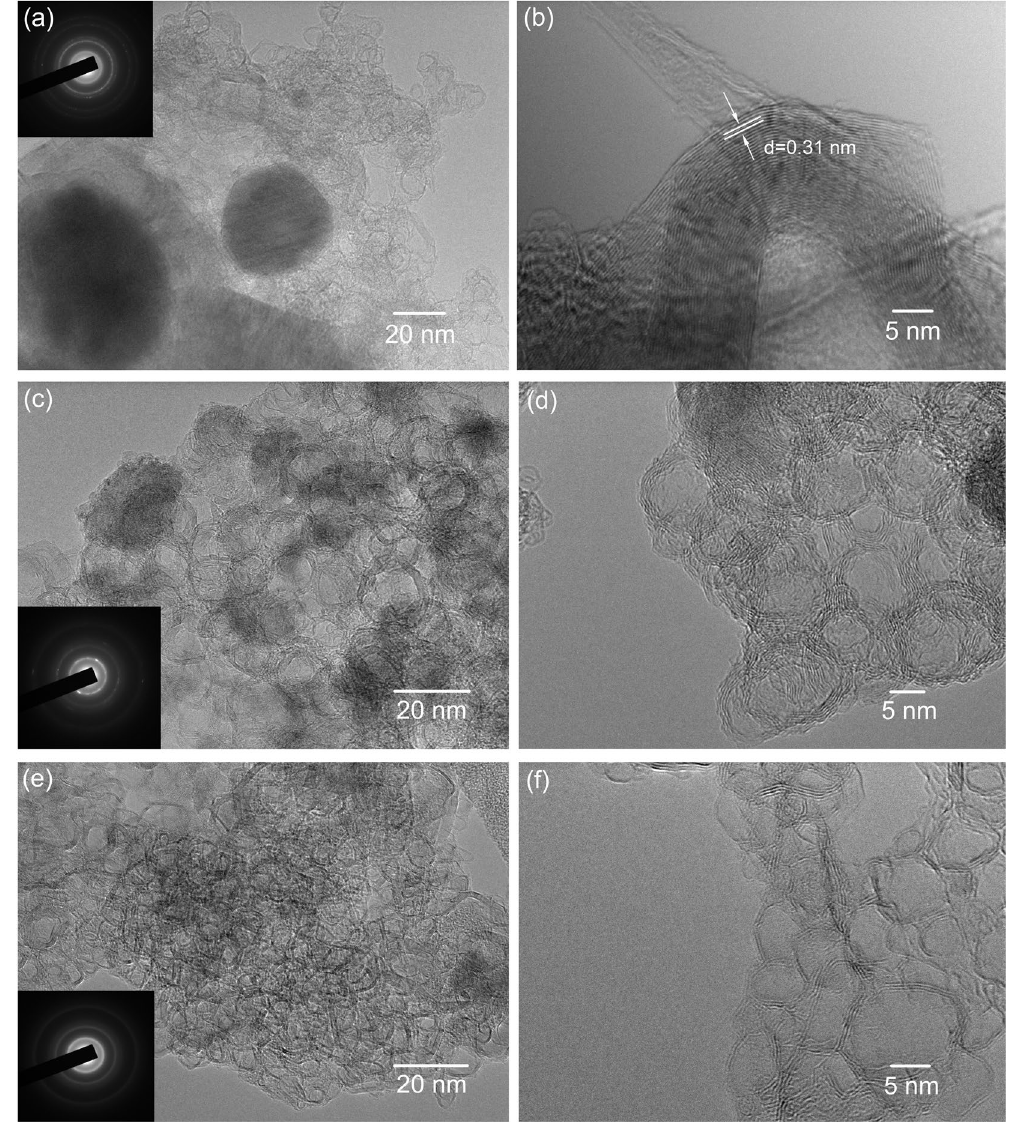
Figure 2. TEM images of the samples prepared under relatively high carbonization temperature. ( a,b ) Co@C- 1200; ( c,d ) Co@C-1600 and ( e,f ) Co@C-2000. Inset: their SAED patterns.